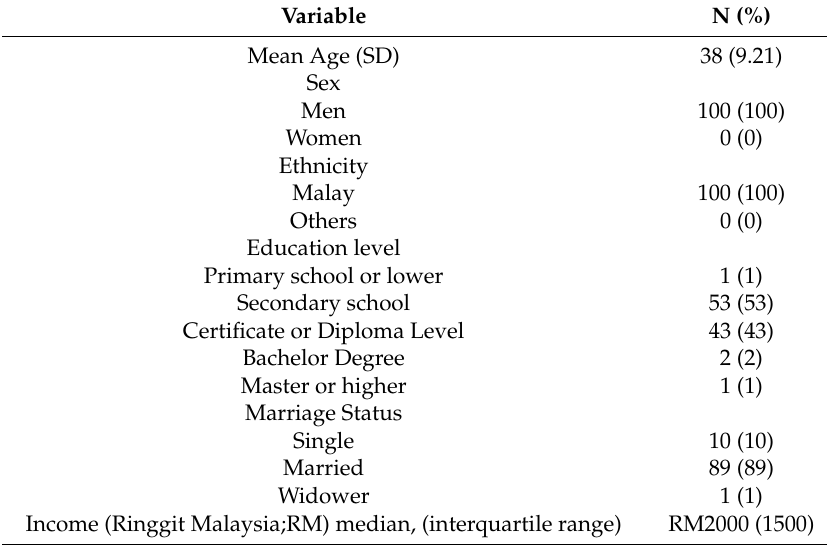
Table 3. Socio-demographic characteristics of the